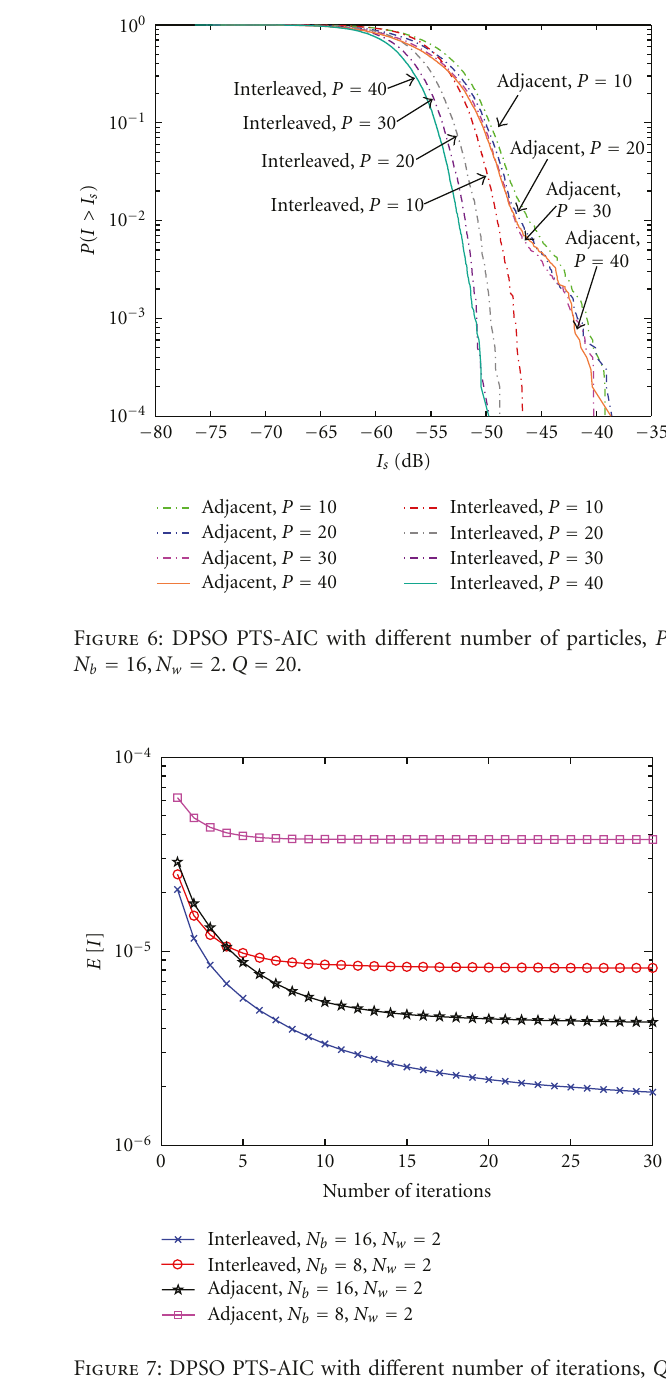
Figure 7: DPSO PTS-AIC with di ff erent number of iterations, Q . P =